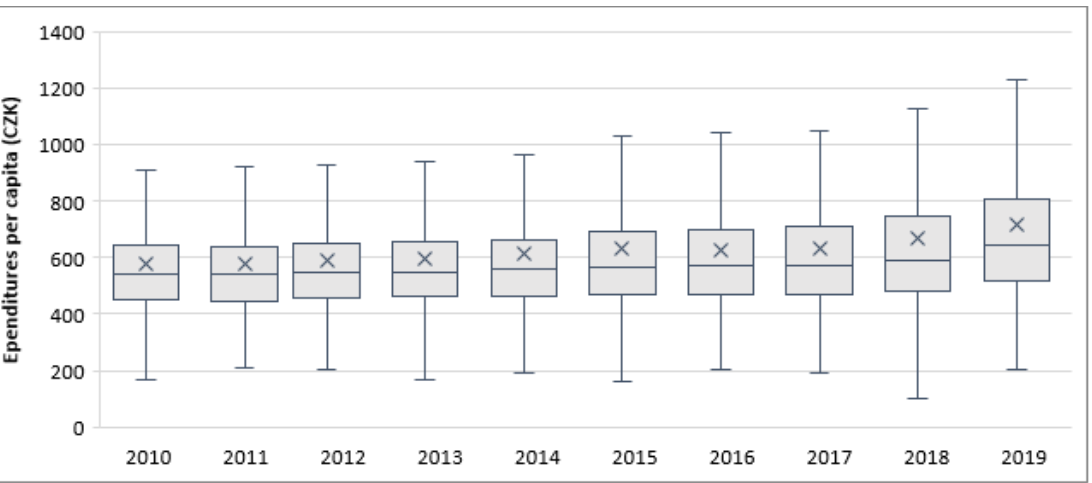
Figure 2. Boxplots of MSWM expenditures per capita during 2010–2019, 664